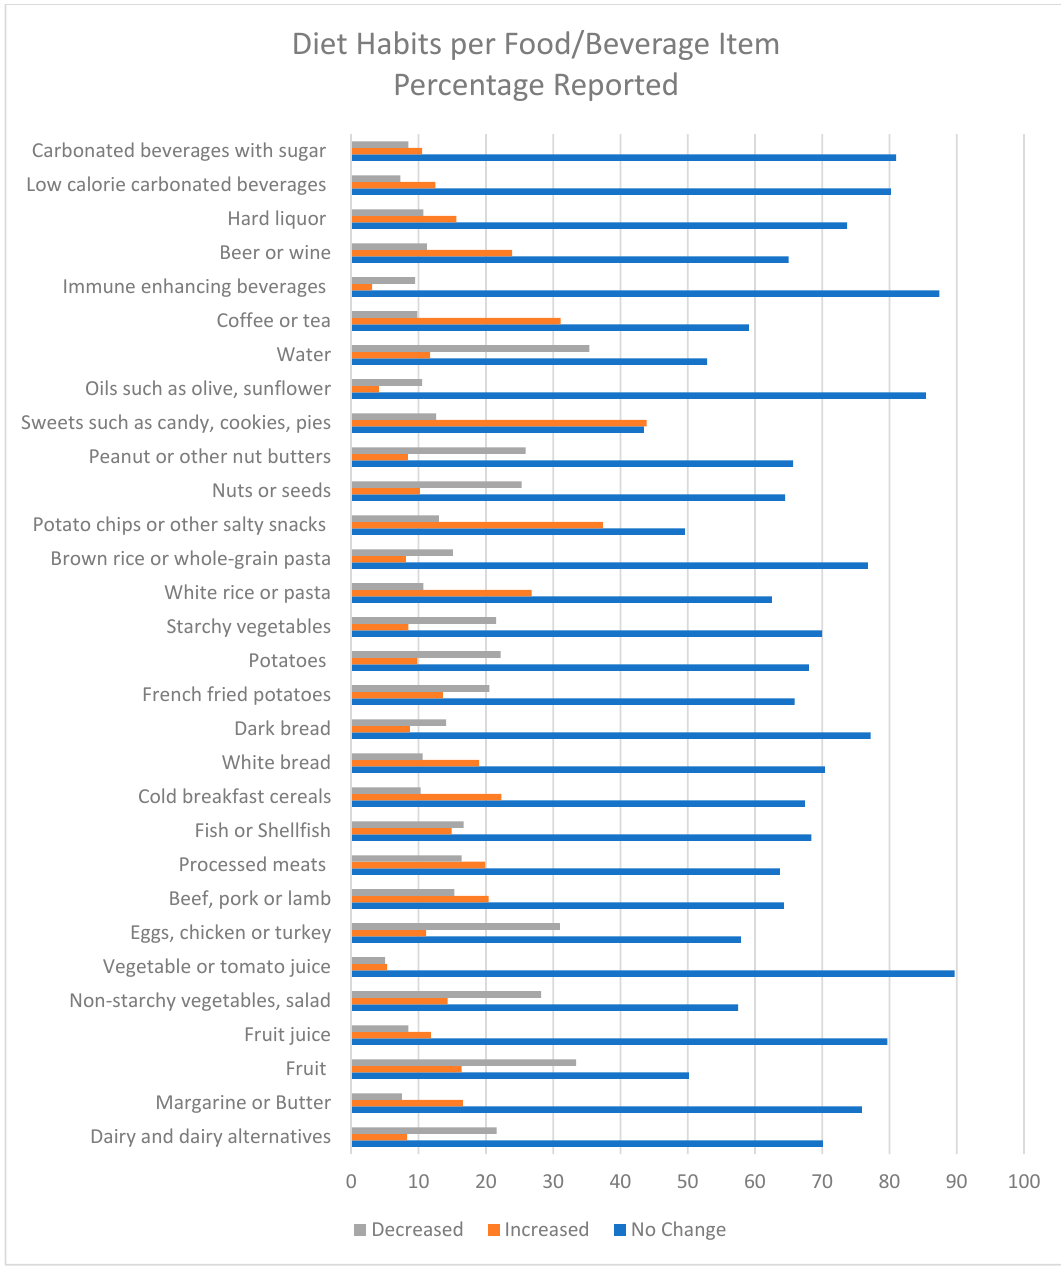
Figure 2. Dietary habits reported by foods/beverages consumed. Data represented as percentages of no-change, increased, or decreased.